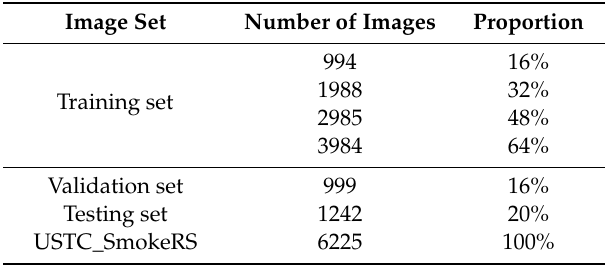
Table 4. Image sets for training, validation, and